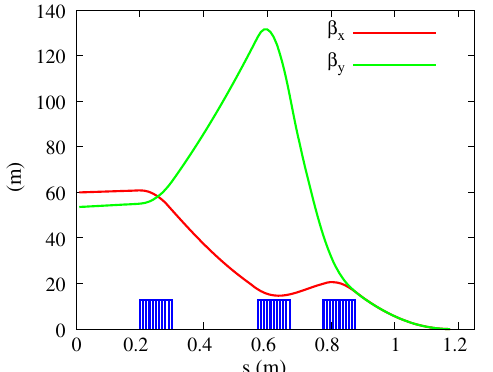
FIG. 11. β x and β y as a function of s in the final focusing section of the design. The locations of the three quadrupoles are shown along the horizontal axis.